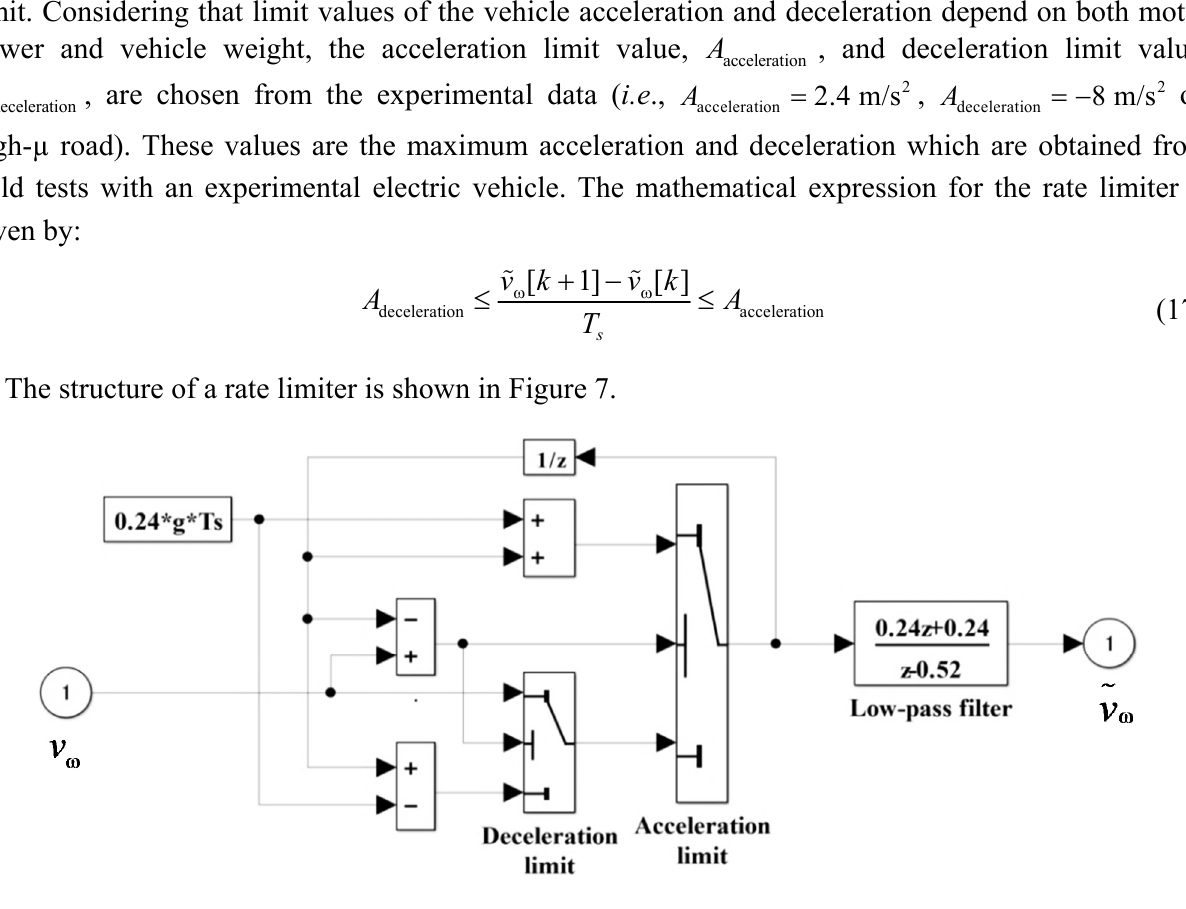
Figure 7. Structure of the rate limiter with a low pass